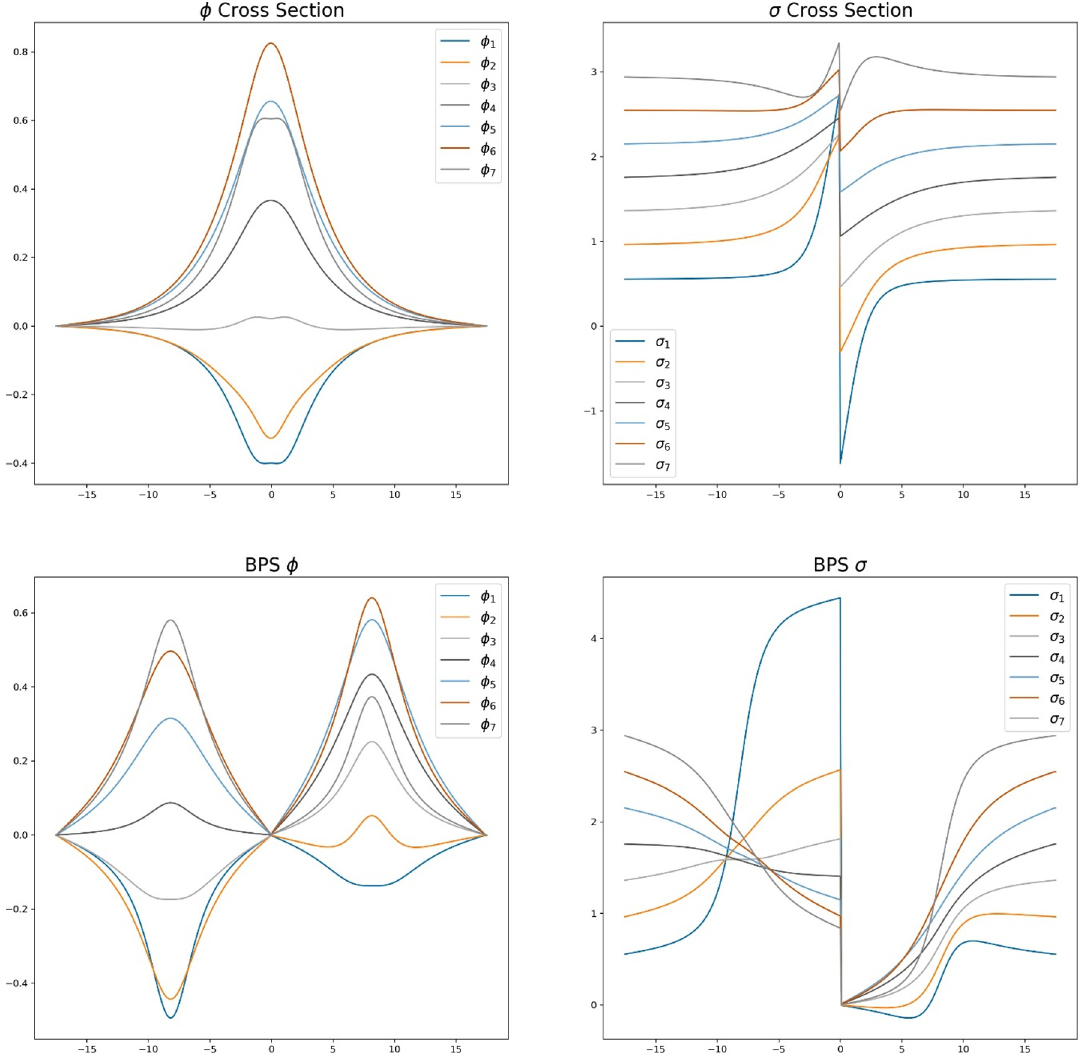
Figure 8. The cross section at the y = 0 midpoint between the w 1 quarks with a collapsed string for N = 8 . The cross section does not match that of a corresponding pair of BPS solitons, in contrast with the cross section of a double-string configuration, as in figure